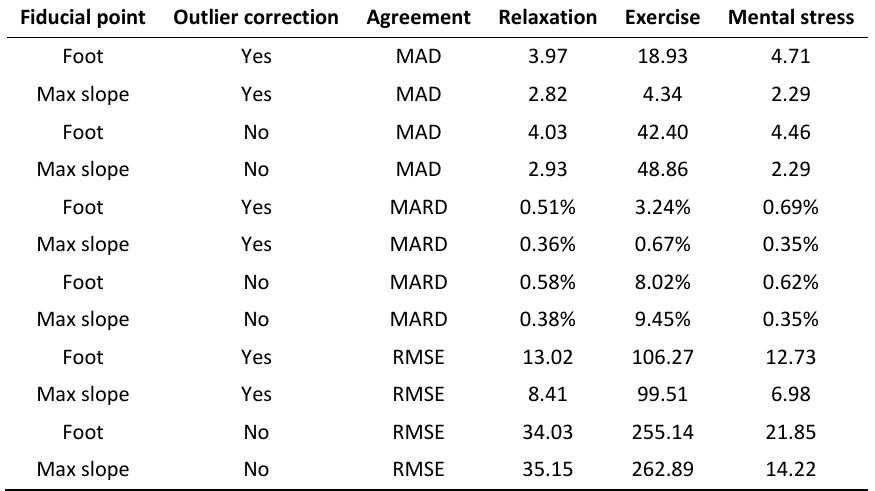
Table 2. Summary of agreement between RR derived from ECG and IBI derived from PPG for each type of activity. The agreement is presented as median absolute deviation (MAD), median absolute relative deviation (MARD) and the root mean square error